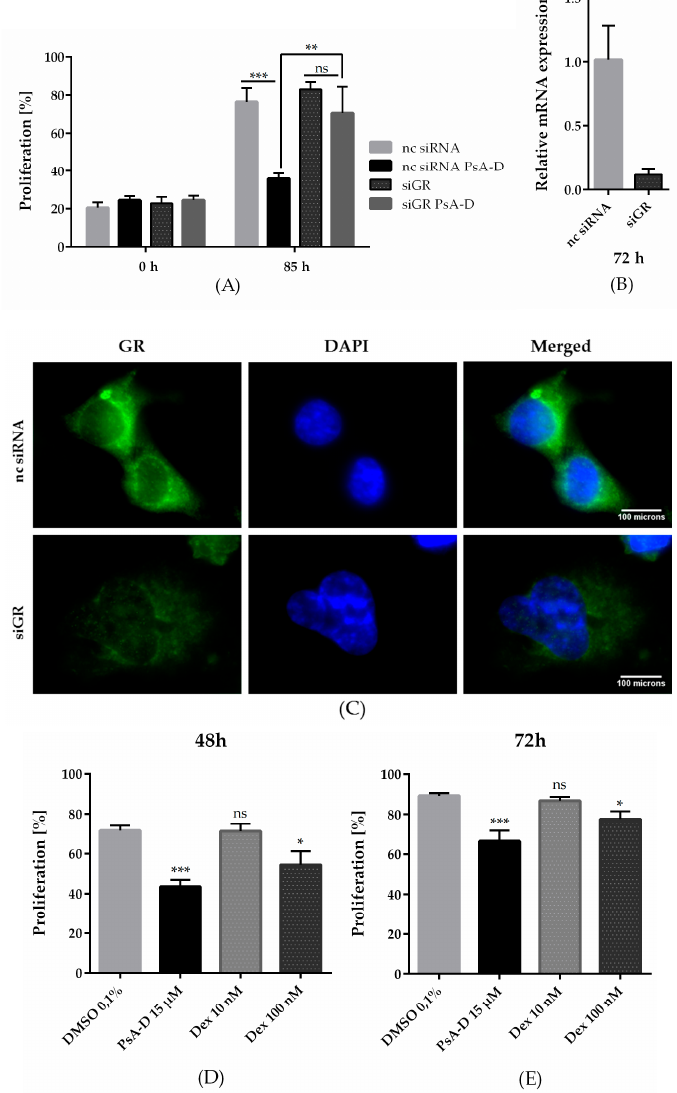
Figure 2. Pseudopterosin failed to inhibit breast cancer cell proliferation after knockdown of the glucocorticoid receptor alpha (GR α ) and inhibited proliferation of MDA-MB-231 more efficaciously than dexamethasone (Dex). ( A ) Knockdown of GR α was done with the Lonza Nucleofector 2b device on day one. On day two, the cells were seeded and proliferating cells were imaged with the IncuCyte ® ZOOM every hour over a time range of five days. Cell proliferation was determined with IncuCyte ® software indicated in percentage. Cells were treated with a concentration of 15 µM of PsA-D. ( B ) After knockdown of GR α , expression of GR α reduced by up to 88.3%, which was confirmed by qPCR analysis at 72 h. ( C ) Immunofluorescent analysis of GR α knockdown after 72 h. Scale bars in white show 100 microns in length. ( D , E ) PsA-D inhibited proliferation after 48 and 72 h more efficaciously than Dex. The data represent means of three independent experiments. Error bars were calculated using ±SEM. One star represents a significance of p < 0.05, two stars of p < 0.01 and three stars represent a significance of p < 0.001. “ns.” means not significant.